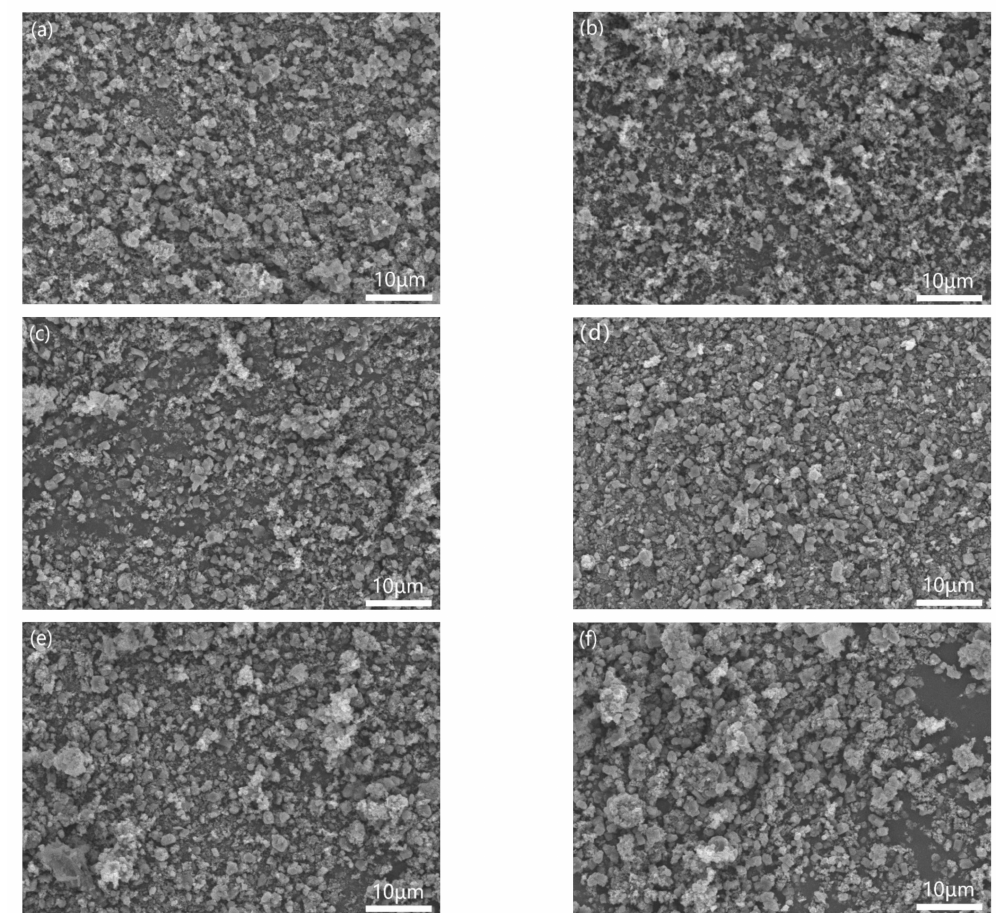
Figure 4. Morphologies of the mixed Al(OH) 3 /carbon black powders with different PVB additions: ( a ) sample A; ( b ) sample B; ( c ) sample C; ( d ) sample D; ( e ) sample E; and ( f ) sample